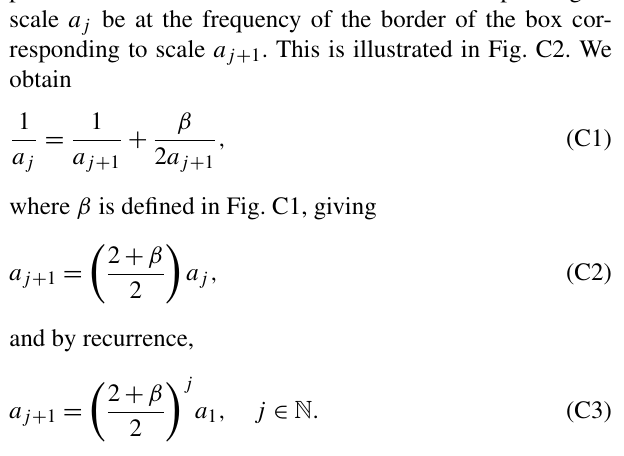
Figure C1. Uncertainty boxes for the Morlet wavelet, with α = √ √ ω 0 / 2 and β = 1 / 2 ω 0 .